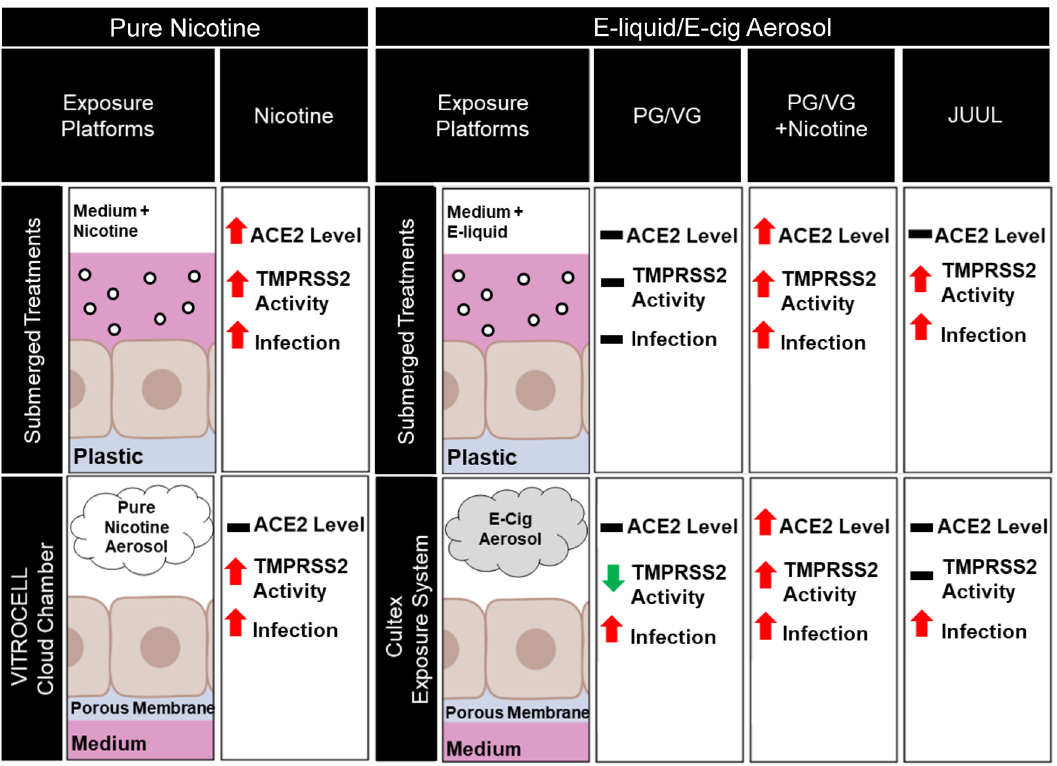
Figure 5. Relationship between JUUL E-liquid, nicotine, and PG/VG exposure and ACE2, TMPRSS2 activity, and viral pseudoparticle infection. Diagram summarizing the major findings in BEAS-2B cells following exposure to JUUL, mixtures (PG/VG plus nicotine), and individual chemicals (nicotine and PG/VG solvent) in three exposure models: submerged treatment (top), air–liquid interface (ALI) exposure in the cloud chamber (bottom left), and ALI exposure to EC aerosols in a Cultex system (bottom right). Increases in ACE2 were only seen in groups containing nicotine or nicotine plus PG/VG. TMPRSS2 activity increased in all groups, except in Cultex aerosols made from PG/VG or JUUL “Tobacco pods”. These two Cultex groups had lower pHs, which likely reduced TMPRSS2 activity. Infection increased in all treatments, except PG/VG in submerged culture. Red arrows indicate a significant increase. Green arrows indicate a significant decrease from the control.